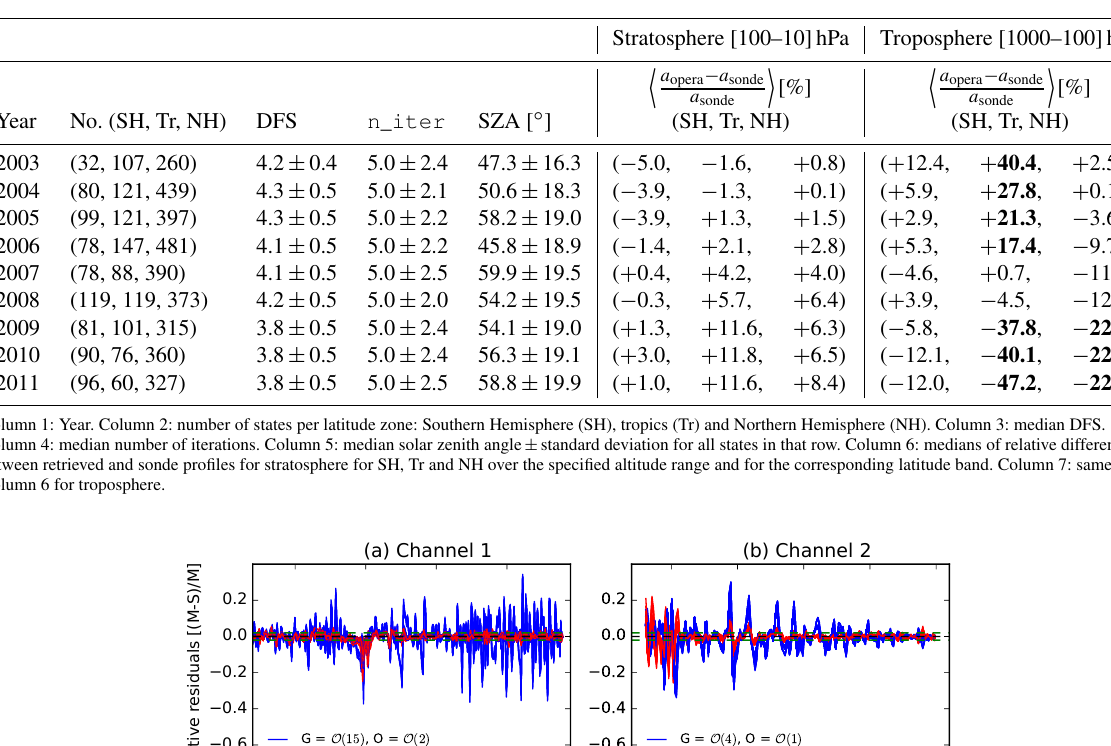
Table 5. Validation statistics of retrieved ozone profiles from L1 v8 for the period 2003–2011. Bold numbers in the medians of relative differences are exceeding ESA CCI accuracy thresholds.